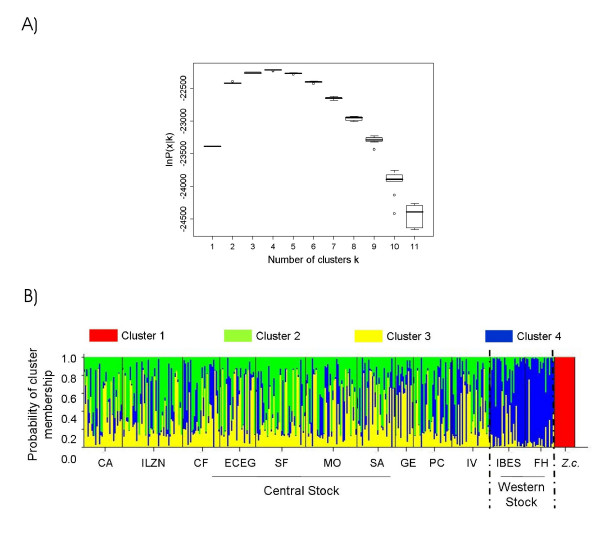
A) Results from ten independent runs of STRUCTURE 2.1 [70] for each hypothesized number k of genetically meaningful clusters using 16 Californian and 367 Galápagos sea lions. Posterior probabilities ln P(x|k) indicate which number of populations are most likely to explain the genotypic data. B) Barplot of membership probabilities for the scenario of population subdivision that was best supported by the data (k = 4). Each individual is represented by a stacked bar that can be partitioned into a maximum of four differently shaded segments, each standing for a genetic cluster. The probability of cluster membership is portrayed by relative segment length for each individual. Colonies of origin and genetic stocks are given below, the Californian sea lion (Z.c.) is included as the outgroup (see Methods).